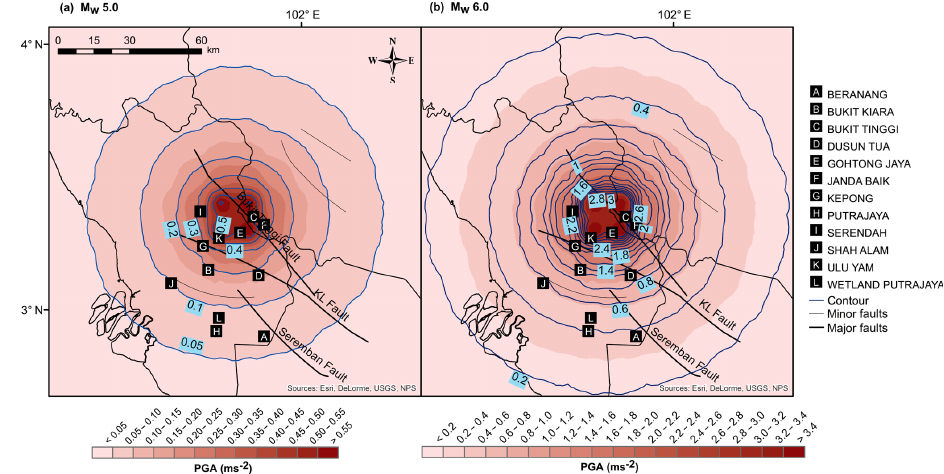
Figure 11. PGA map based on a simulated event of M w 5 . 0 and 6.0 from the Bukit Tinggi fault.